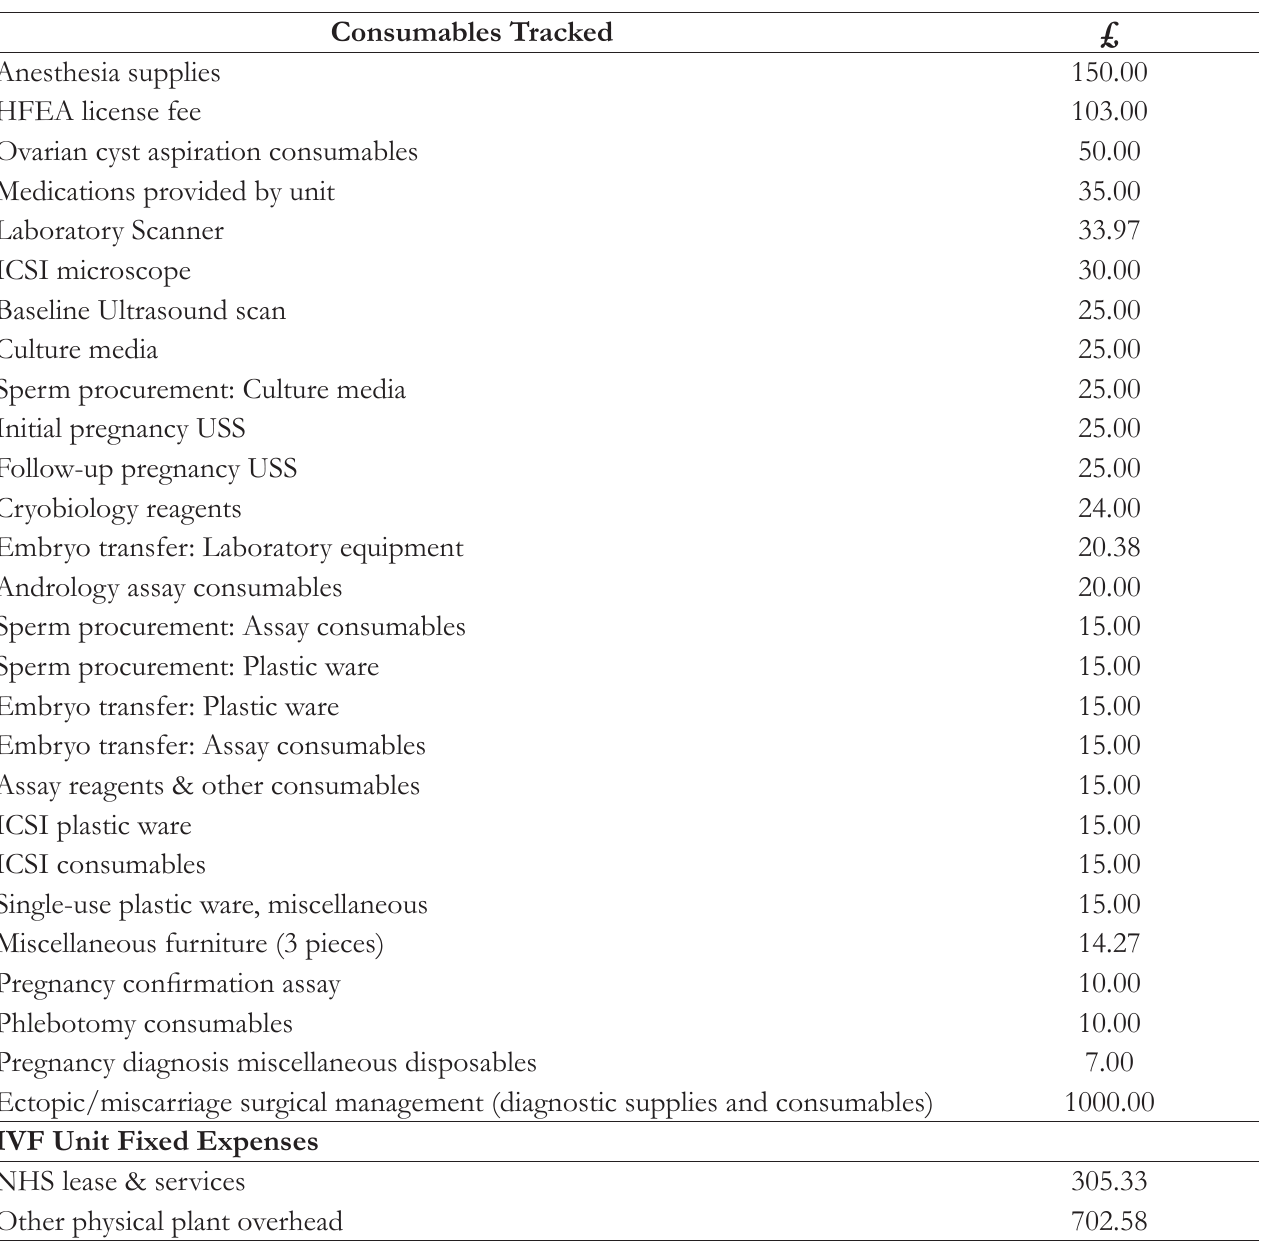
Table 2. Outline of Fixed Expense and Consumable Cost Data for Time-motion Comparison between First and Second IVF Cycles in a UK Fertility Unit (GBP,